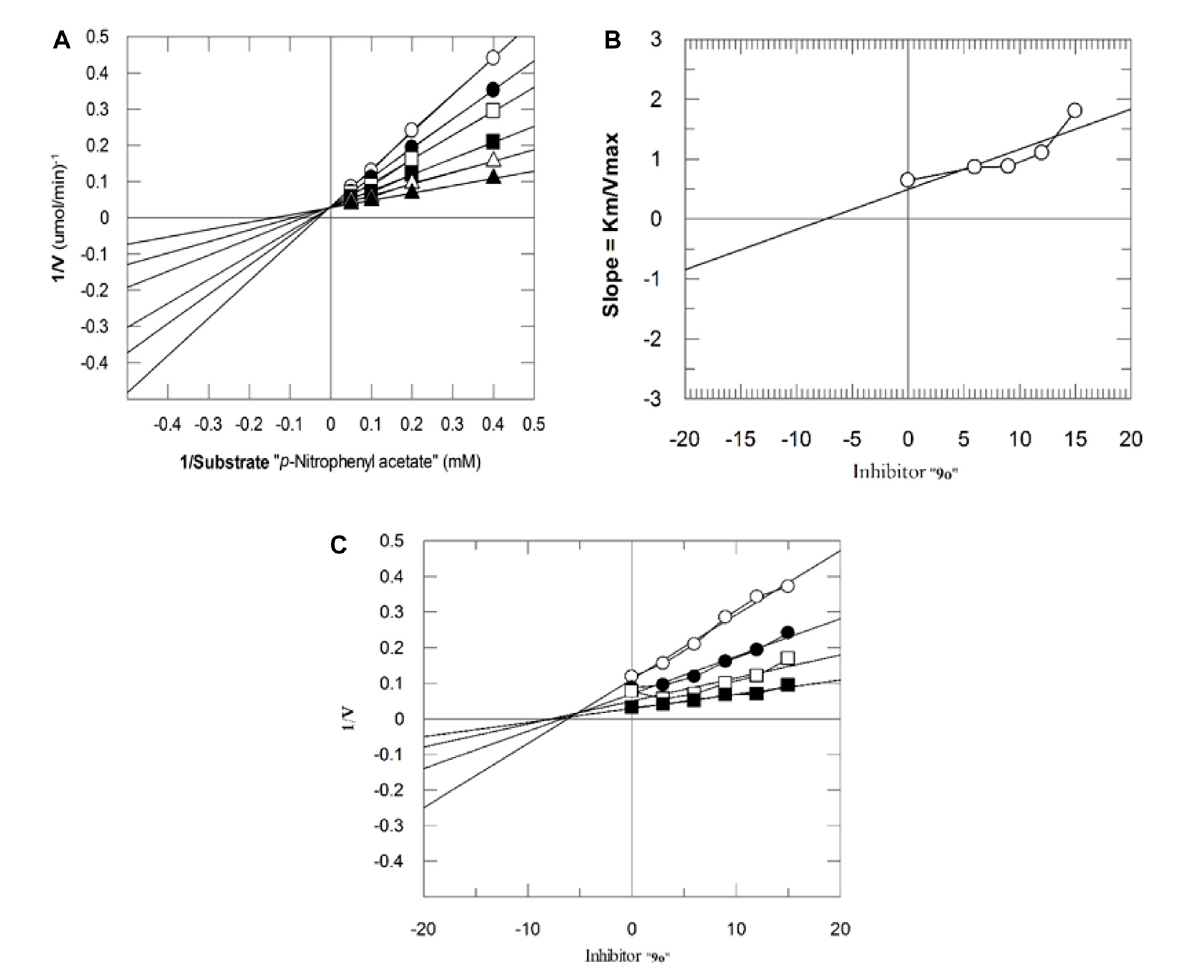
FIGURE 2 Inhibition of hCA-II by 9o . (A) Lineweaver – Burk plot of the reciprocal of the rate of reaction (velocities) vs . reciprocal of the substrate (p-nitrophenylacetate)intheabsence( ▲ ),6 µ M( Δ ),9 µ M( ■ ),12 µ M( □ ),15 µ M( C ),and18 µ M( ○ )of 9o . (B) SecondaryreplotoftheLineweaver – Burk plot between the slopes of each line on the Lineweaver – Burk plot vs . different concentrations of 9o . (C) Dixon plot of the reciprocal of the rate of reaction ( velocities ) vs . different concentrations of 9o .